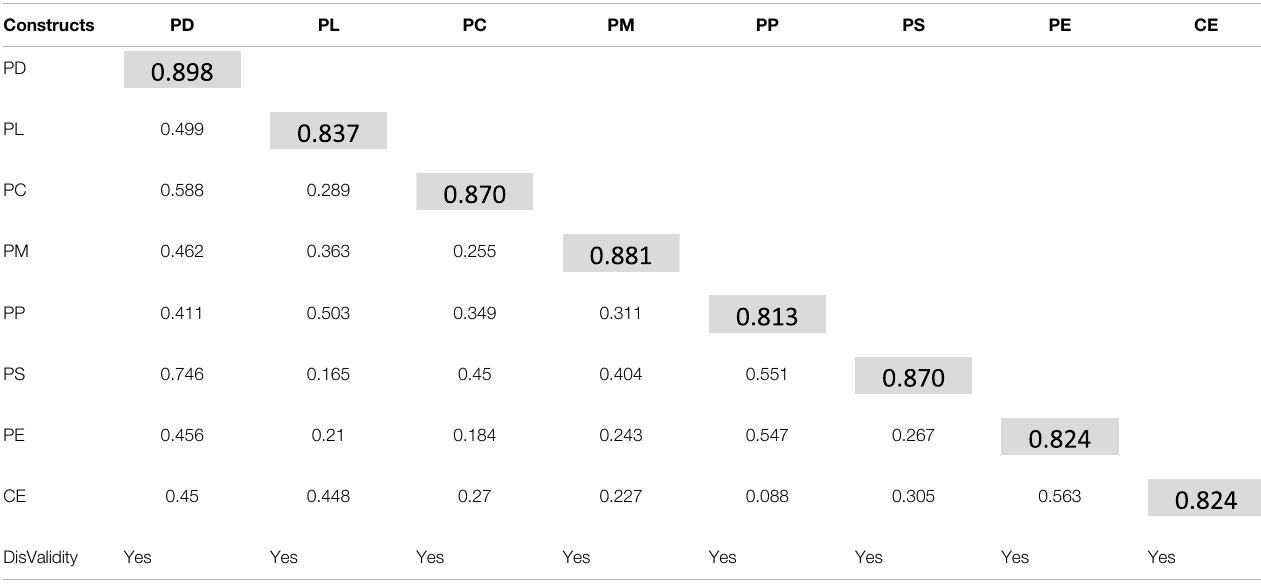
TABLE 9 | Correlation coef fi cient and squared root of AVE for the customer. Constructs